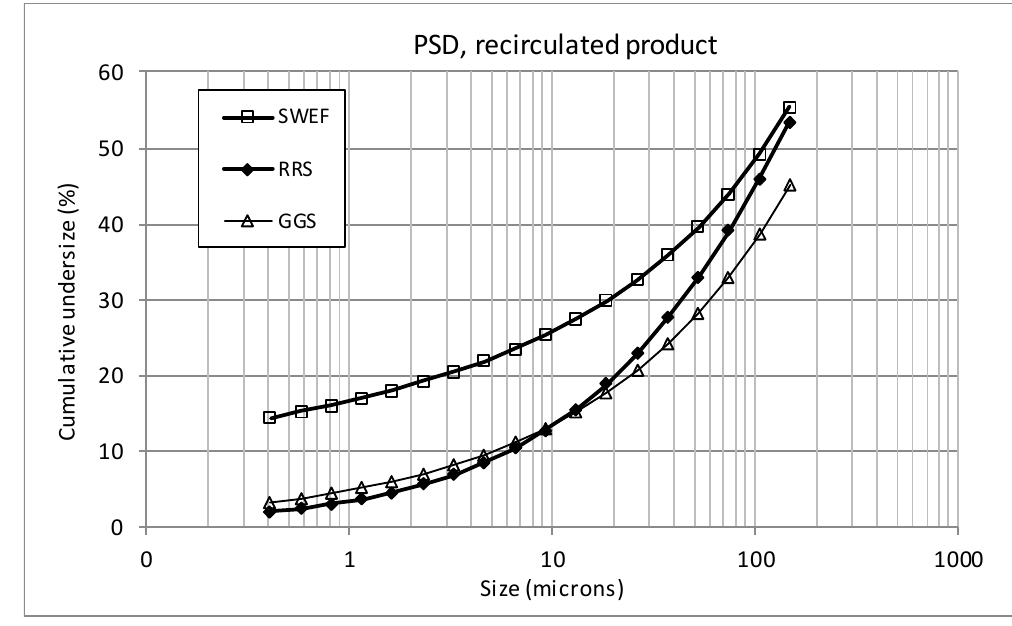
Figure 5. Particle size distribution of the product recirculated in the grinding circuit.